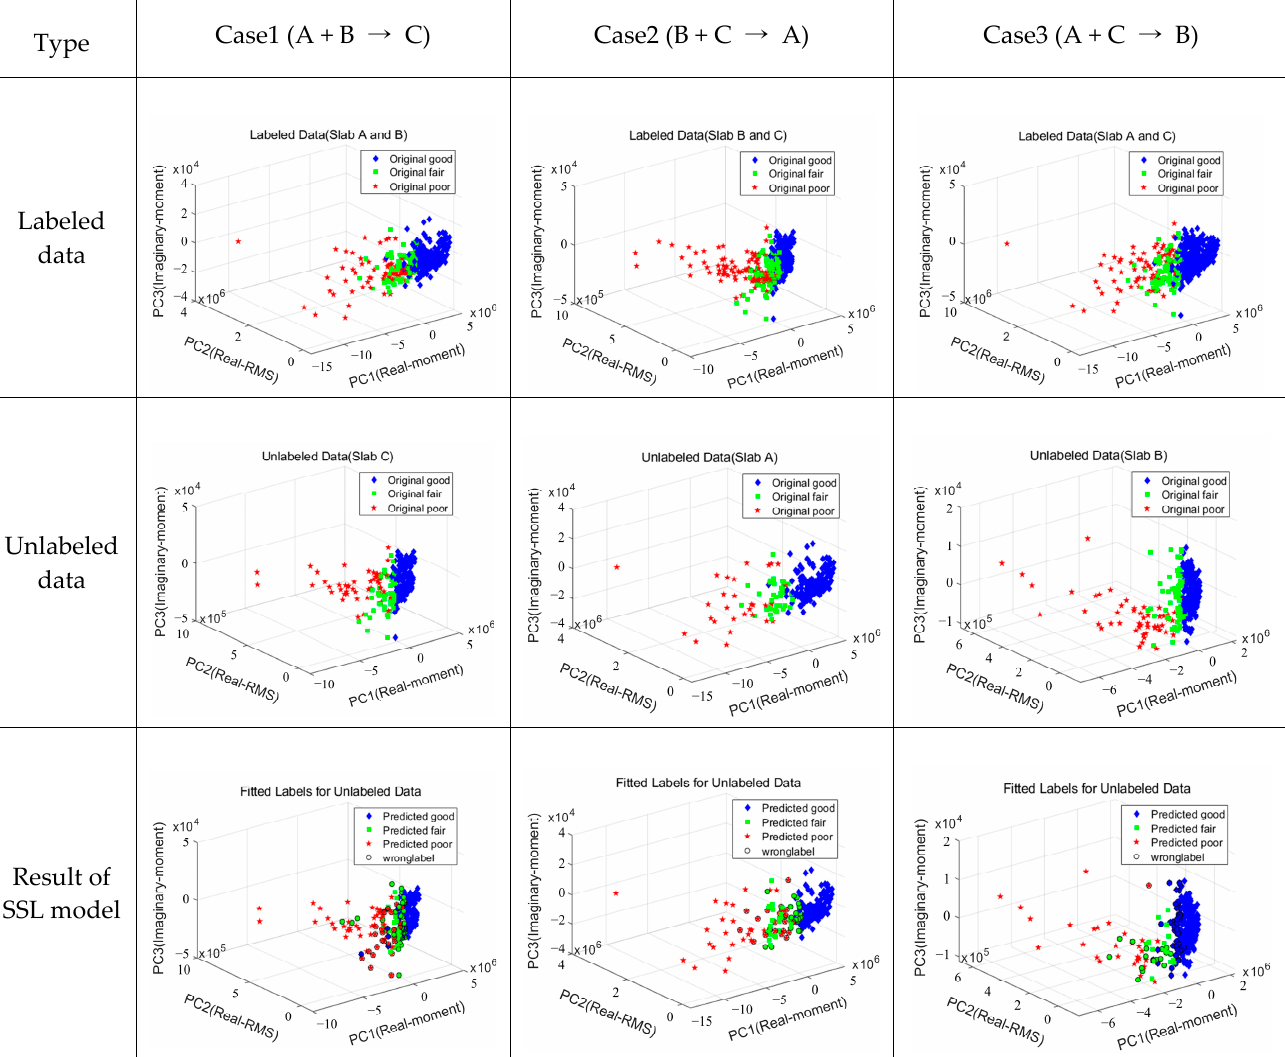
Figure 11. SSL model accuracy analysis by combination.